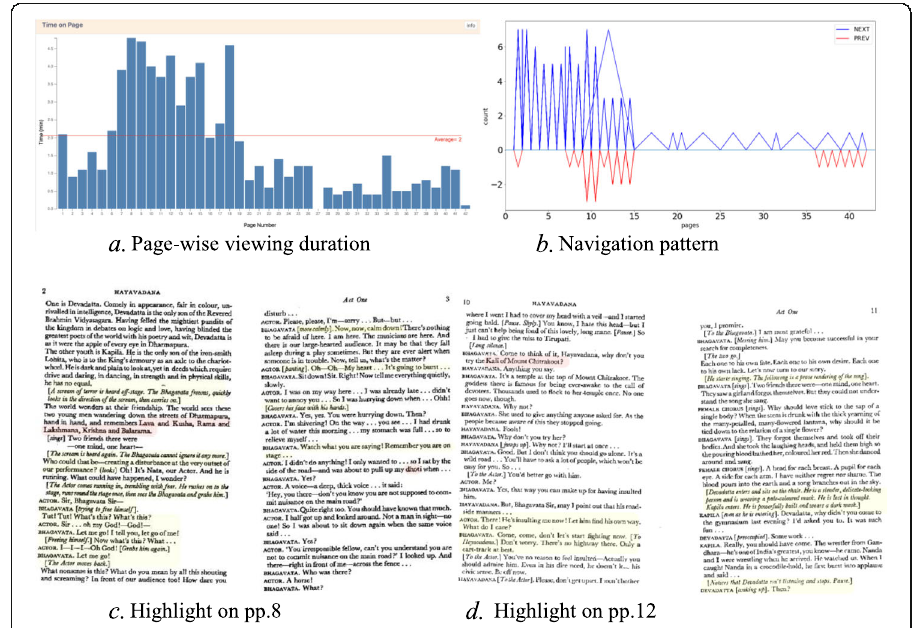
Fig. 8 a Page-wise viewing duration. b Navigation pattern. c Highlight on pp.8. d Highlight on